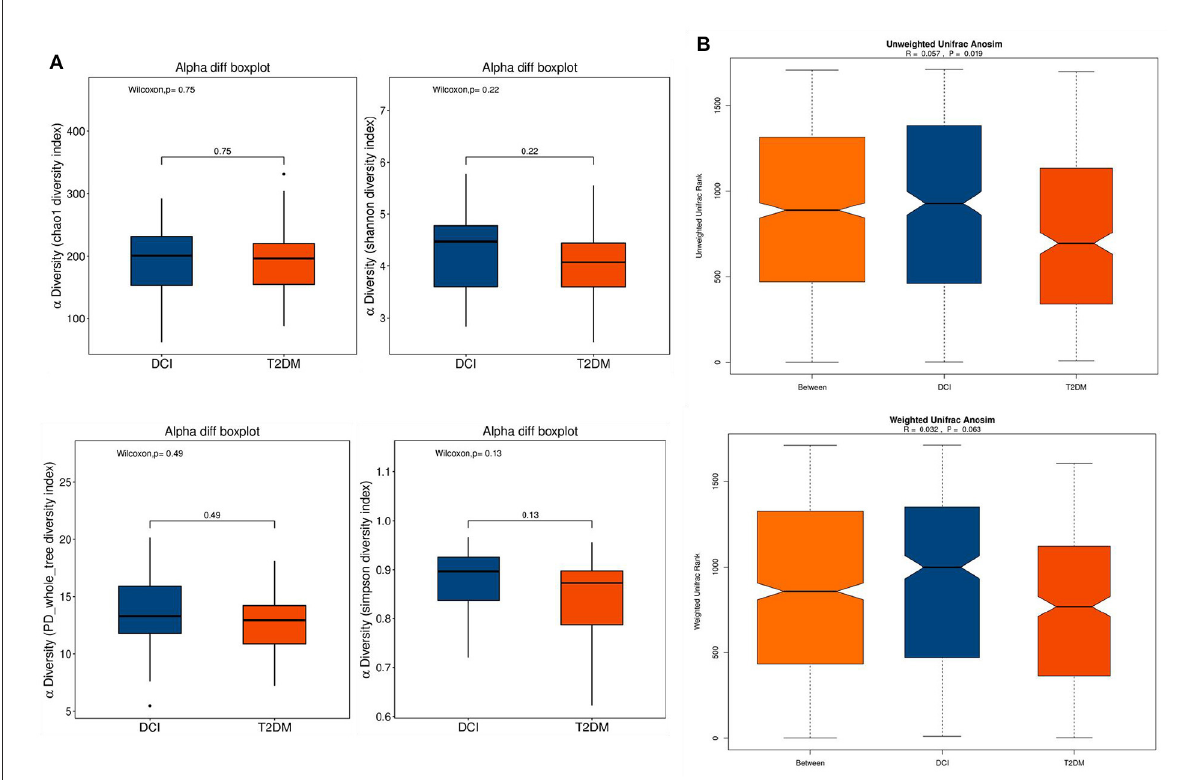
FIGURE1 The α -diversity and β -diversity indices of the fecal microbiota in DCI and T2DM groups. (A) Box plots depict differences in the fecal microbiota diversity indices between the two groups according to the Chao1, Shannon, PD whole tree and Simpson indices based on the OTU counts. Each box plot represents the median, interquartile range, minimum, and maximum values. (B) Unweighted and weighted ANOSIM Unifrac analysis based on the distance matrix of UniFrac dissimilarity of the fecal microbial communities in DCI and T2DM groups. Respective ANOSIM R values and significant P -values show the community variation between two groups. The axes represent the two dimensions explaining the greatest proportion proportion of variance in the communities. OTU, operational taxonomic unit, ANOSIM, analyses of